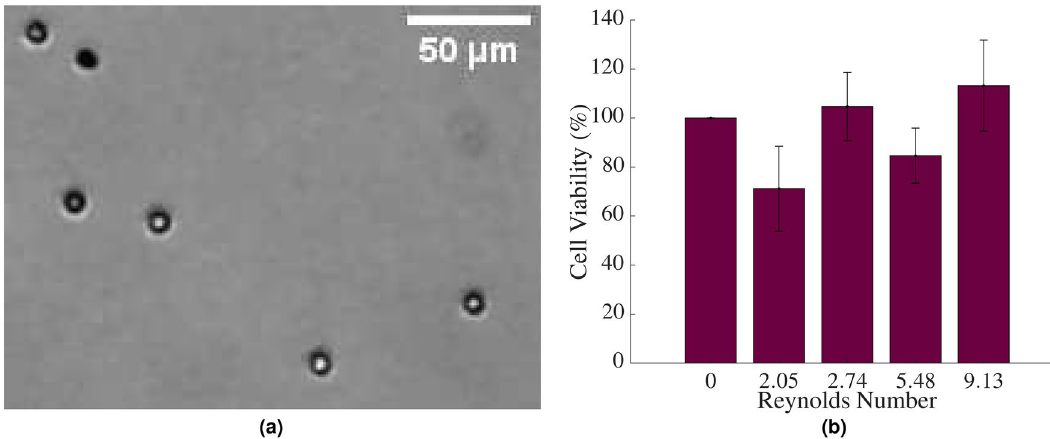
Figure 2. (a) T-cells following suspension in Poiseuille flows of Re = 5.48 for 24 h, stained with trypan blue. (b) The viability of T-cells in circulation, assessed using MTT. Statistical analysis was conducted using two- way ANOVA. Results were normalised to static cells in suspension (or Re of 0). n = 9 replicates, vertical bars represent the